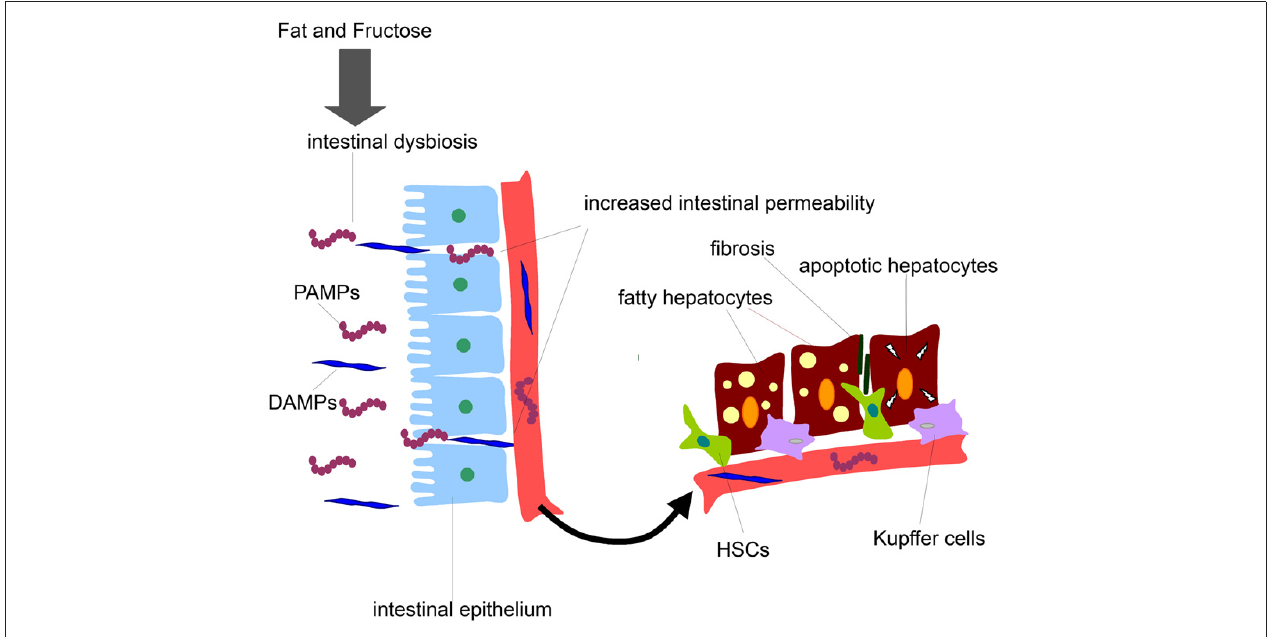
FIGURE 1 | Gut-derived product effects on liver cells during NAFLD development. Diets enriched in fat and fructose may disrupt intestinal barrier, increase intestinal permeability to gut-derived products, and release